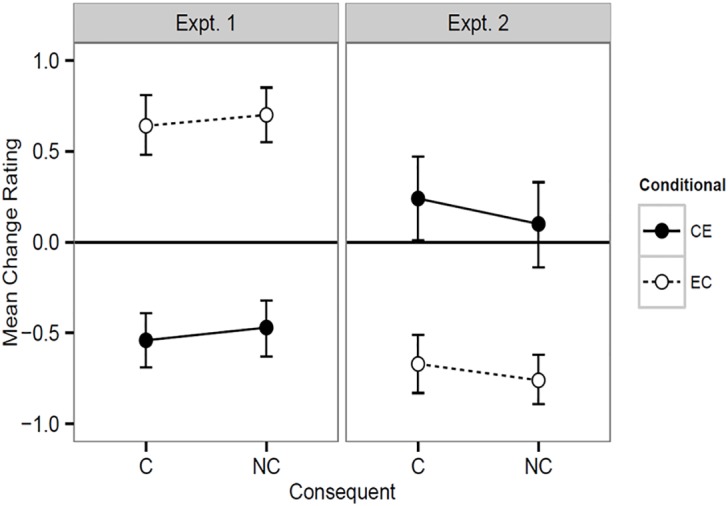
The results of Experiments 1 and 2.Expt. 1 (EC-AND, CE-OR), means and 95% confidence intervals (CIs) based on Model 3 in Table 1. Expt. 2 (EC-OR, CE-AND), means and 95% CIs based on Model 4 in Table 2.